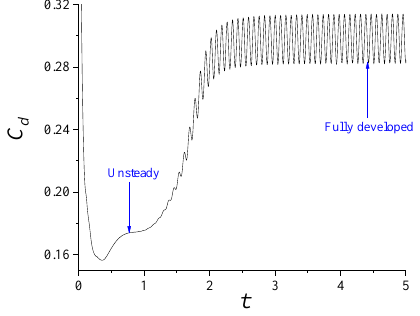
Figure 7. Drag curve of the hydrofoil under convergent conditions.